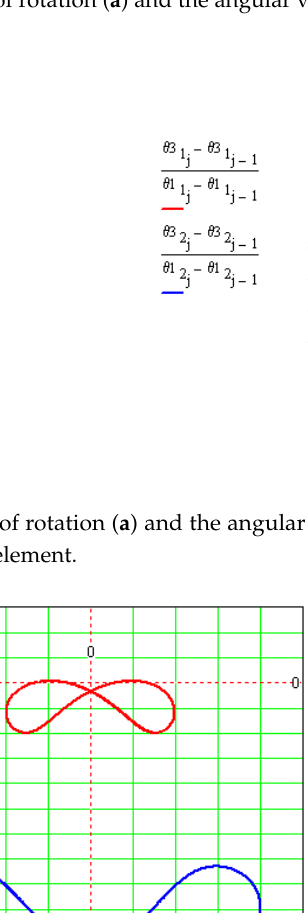
Figure 18. The angle of rotation ( a ) and the angular velocity of the driven element ( b ).